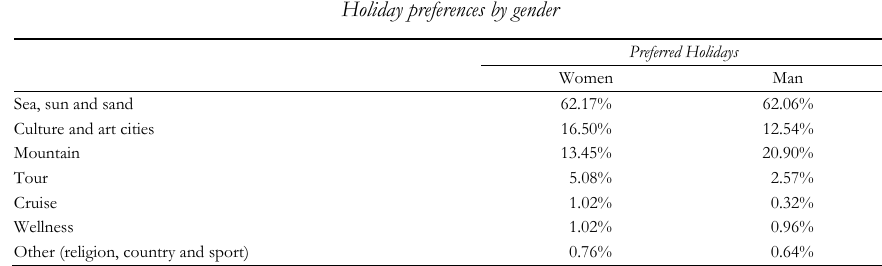
Holiday preferences by gender